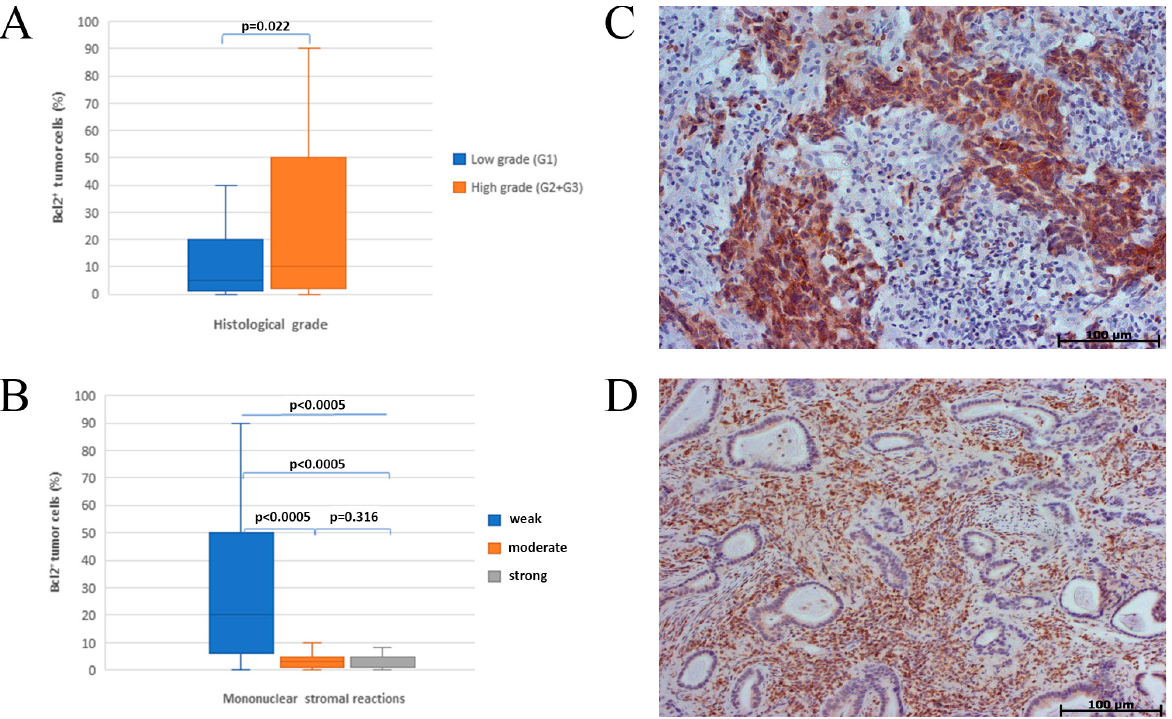
Figure 1. Association of Bcl-2 expression with histological grade and mononuclear stromal reaction; ( A ) influence of histological grade on bcl-2 expression; histomorphological presentation of positive